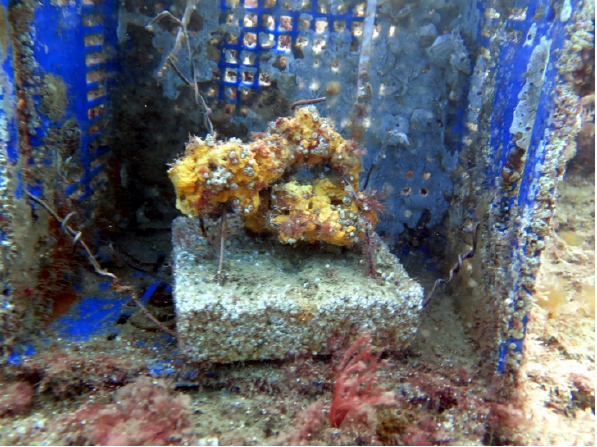
Figure 6. Transplanted A. oroides . The sponge was isolated from its mesophotic habitat, secured to a base and transferred to a protected surrounding in shallow water. Concrete base length is 18 cm.